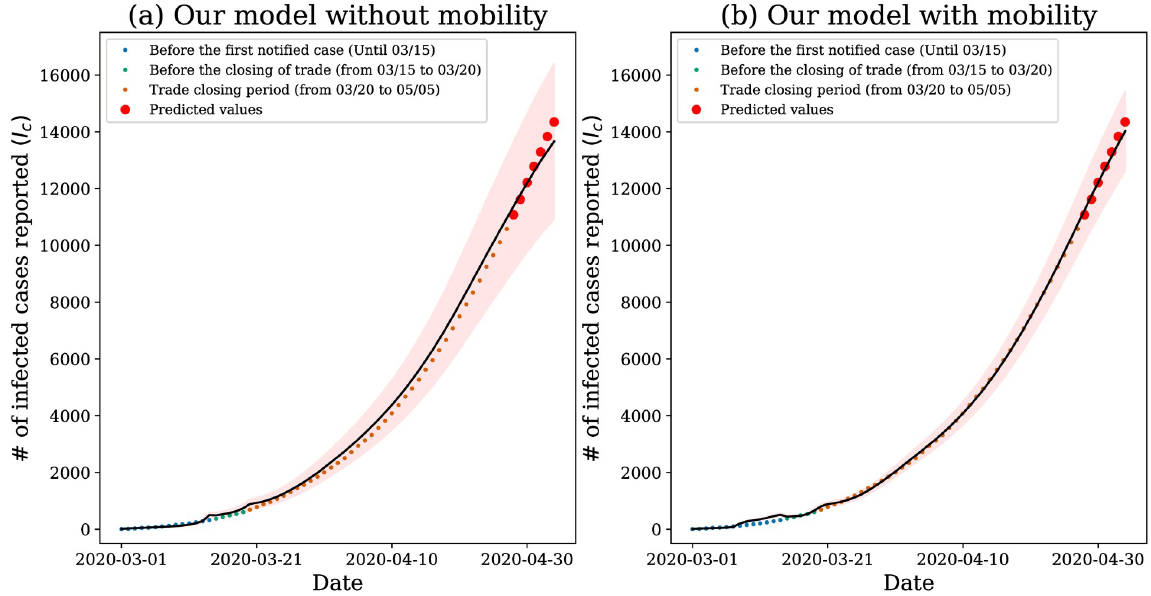
Fig 11. Model results. Our model applied to data from the city of Fortaleza. The shaded areas represent the 95% confidence region provided by the model; the black line represents the average model prediction and the points the official values released.